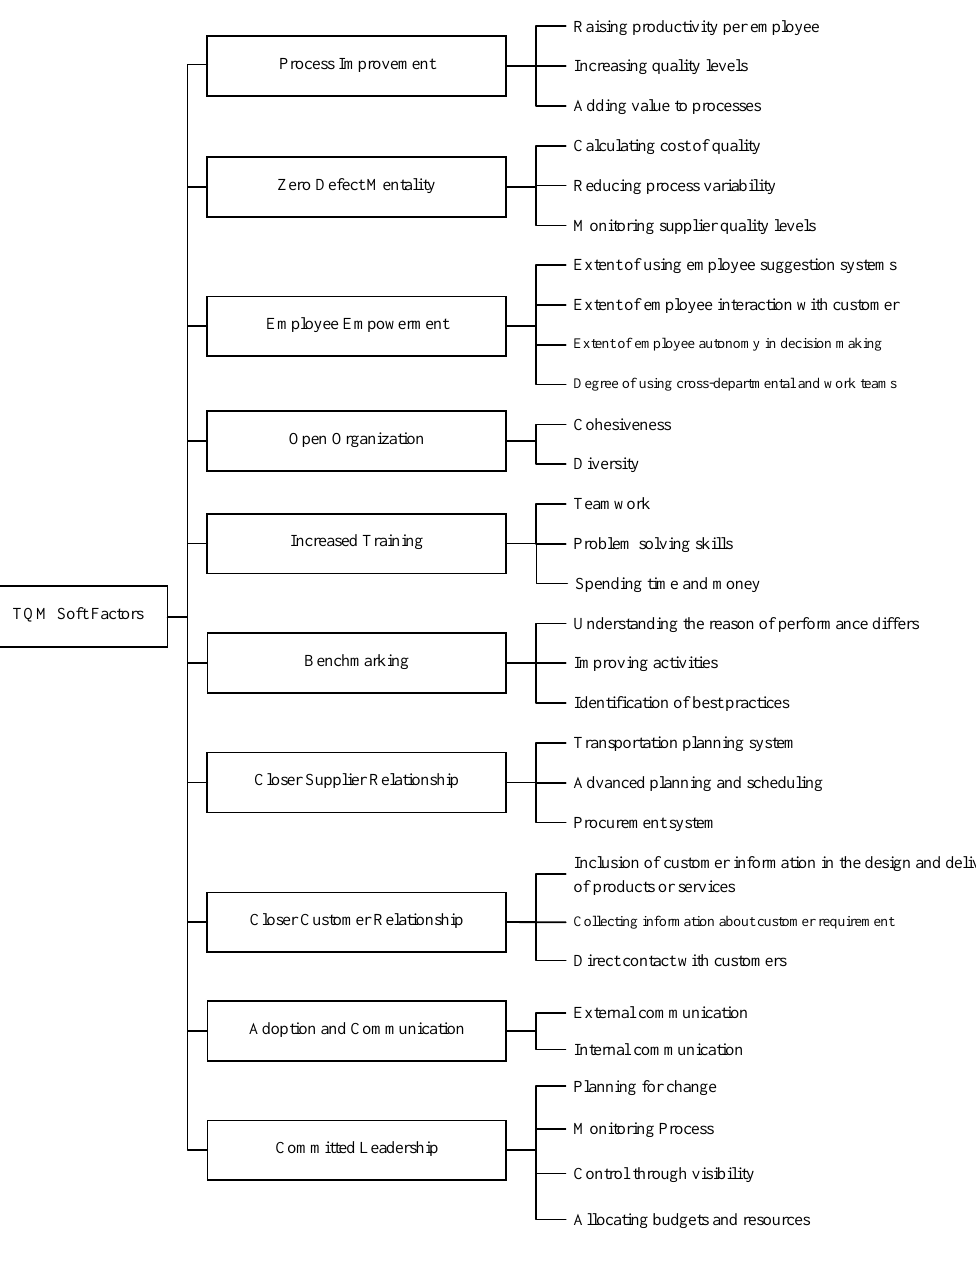
Figure 1. "The proposed framework of TQM soft